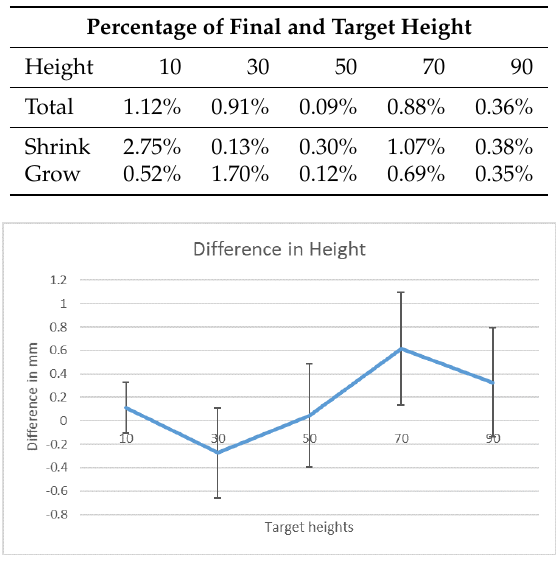
Figure 9. Difference of final and target height in mm for height adjustment (error bars depict standard error of the overall mean values).